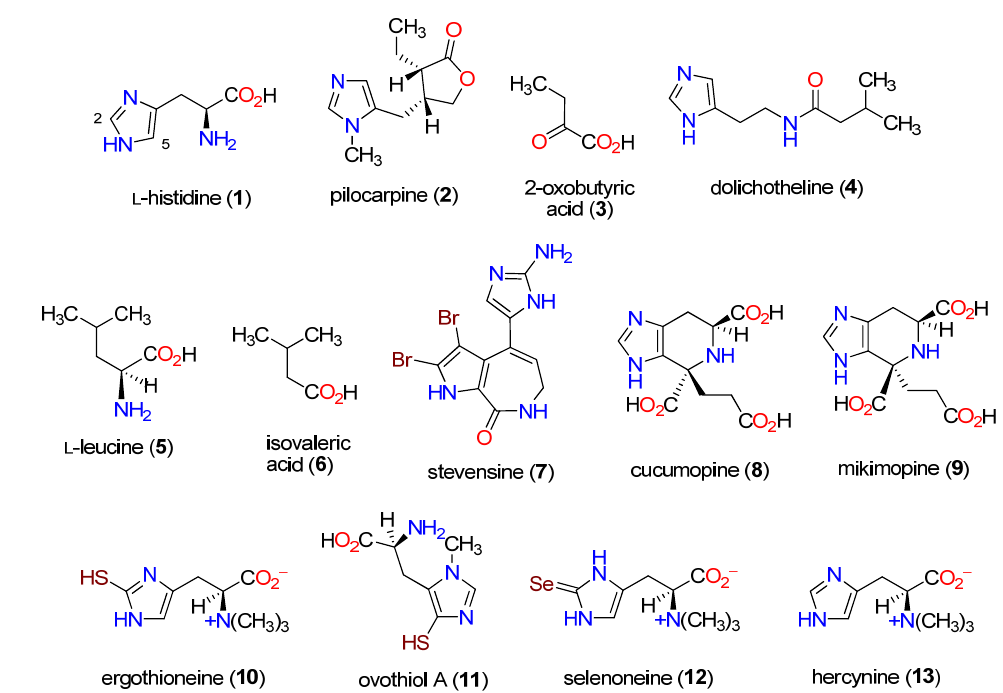
Figure 1. Representative histidine-derived alkaloids.